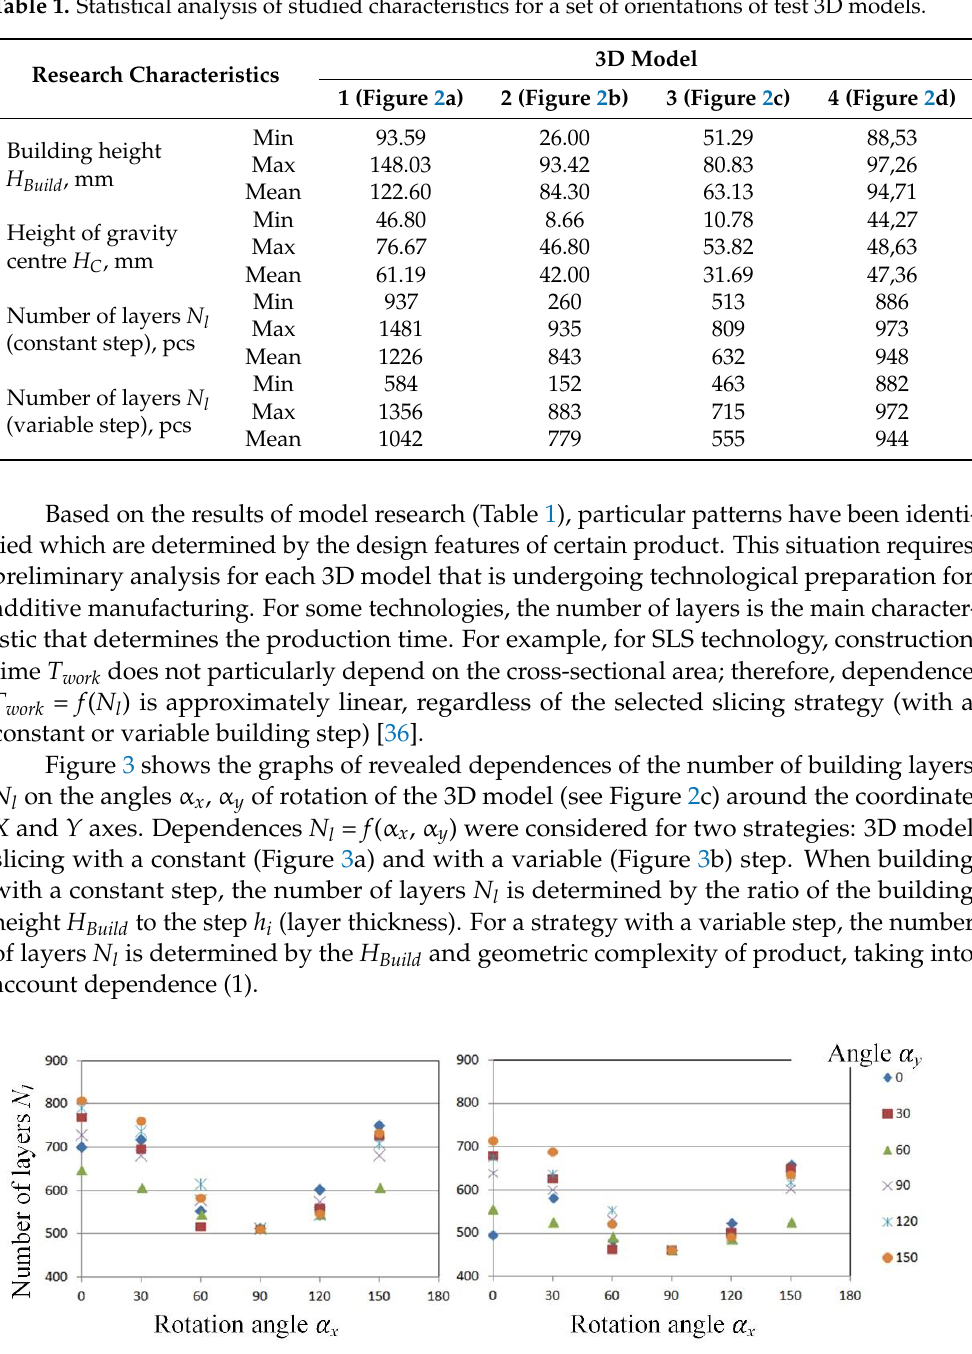
Table 1. Statistical analysis of studied characteristics for a set of orientations of test 3D models.